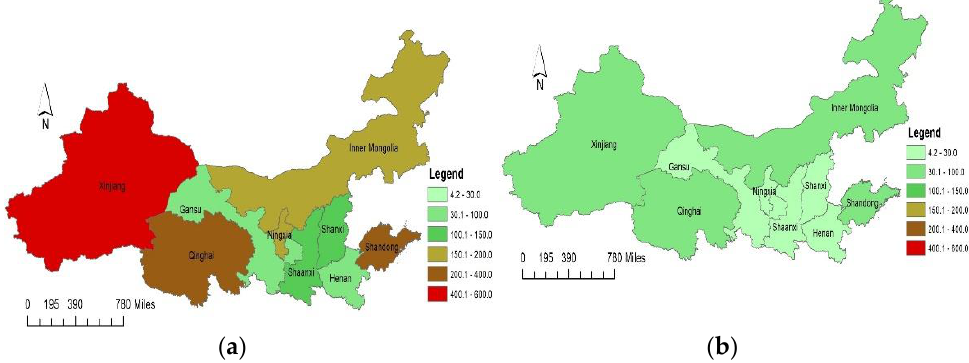
Figure 4. Virtual water outflow of each province in the Yellow River Economic Belt. (( a ) Outflow within the Yellow River Economic Belt ( b ) Flowing into provinces outside the Yellow River Economic Belt).